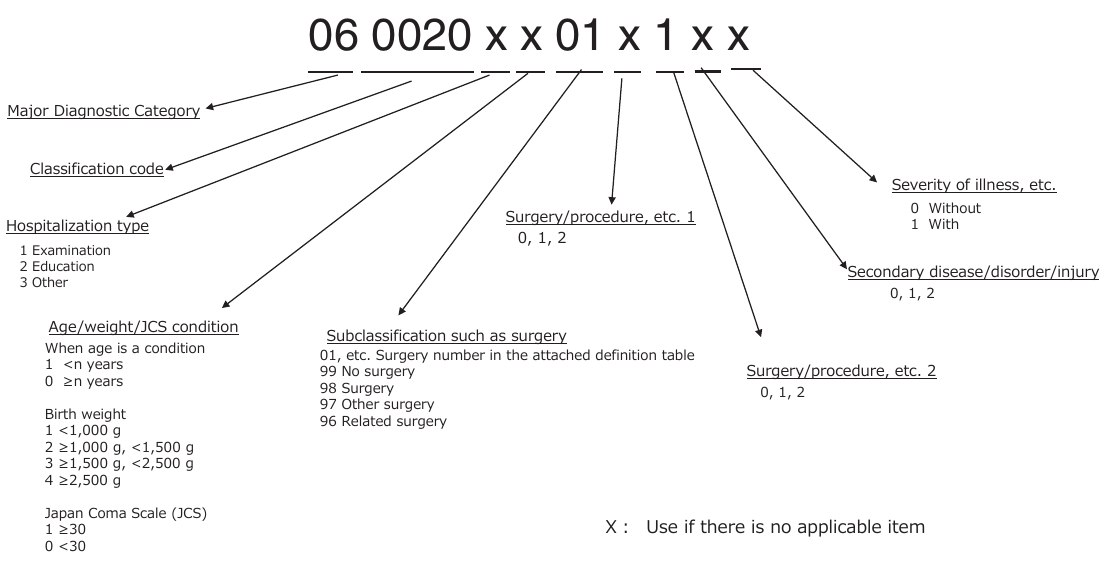
Figure 4. Structure of fi rst Diagnosis Procedure Combination codes (as of Apr